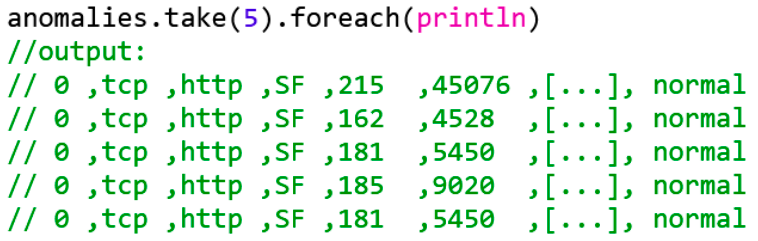
Figure 12. Output of the first five anomalies.